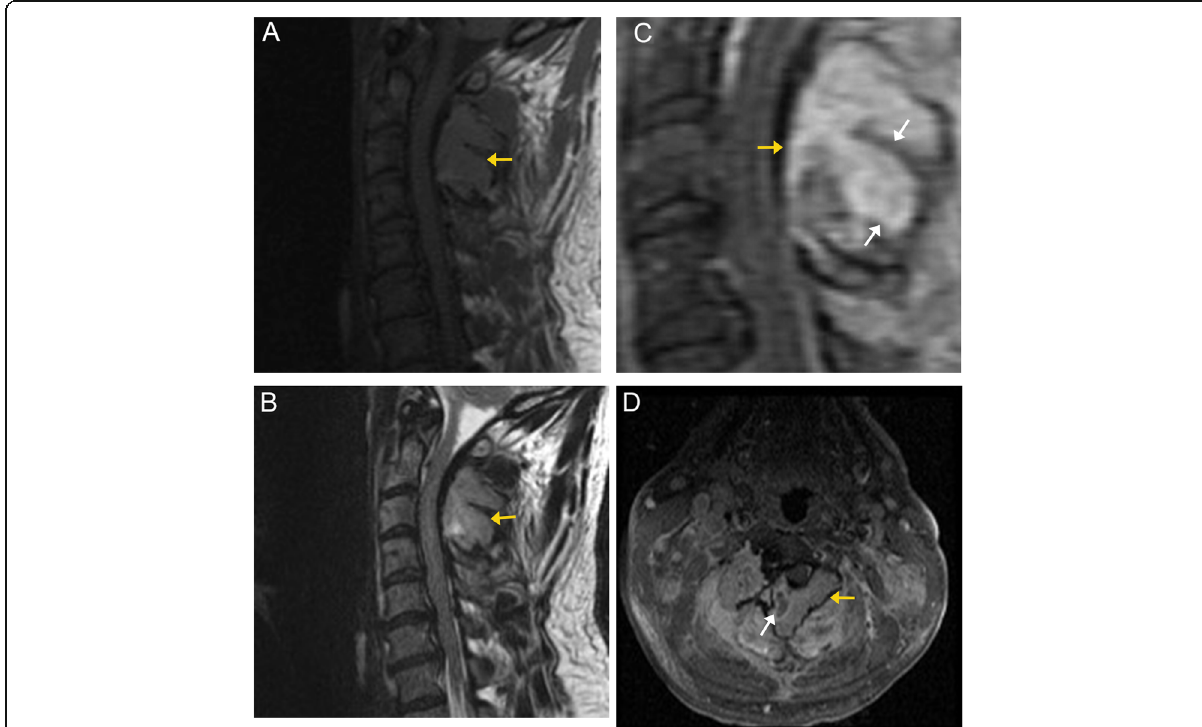
Fig. 15 Plasmacytoma. Sagittal and axial MR images demonstrate an expansile mass (orange arrows) arising from the posterior elements of C2 and C3. The mass demonstrates hypointense signal to normal marrow on T1 ( a ), and isointense to hyperintense signal on T2 ( b ). Post-contrast sagittal T1 ( c ) and axial T1 fat-suppressed ( d ) sequences demonstrate enhancement. A few areas of curvilinear low-signal intensity are seen at the remaining thickened bony cortex (white arrows), projecting into the lesion, resulting in a “ mini-brain ” appearance resembling cortical